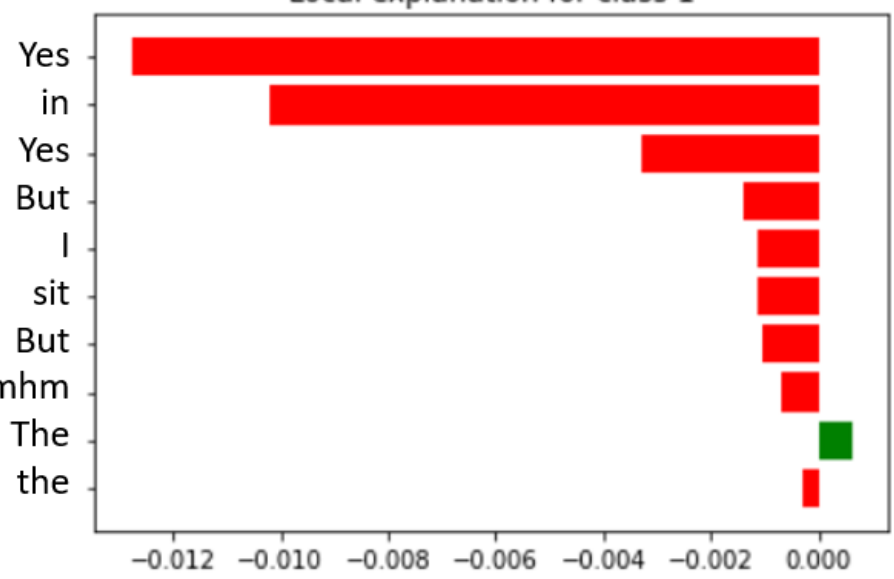
Figure 9. LIME explanation for quote 2 (top 10 words and how much they approximately contribute to the classification